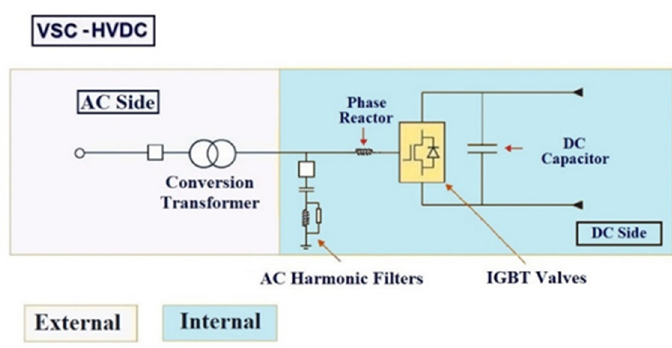
Figure 8. CSC-HVDC main components.